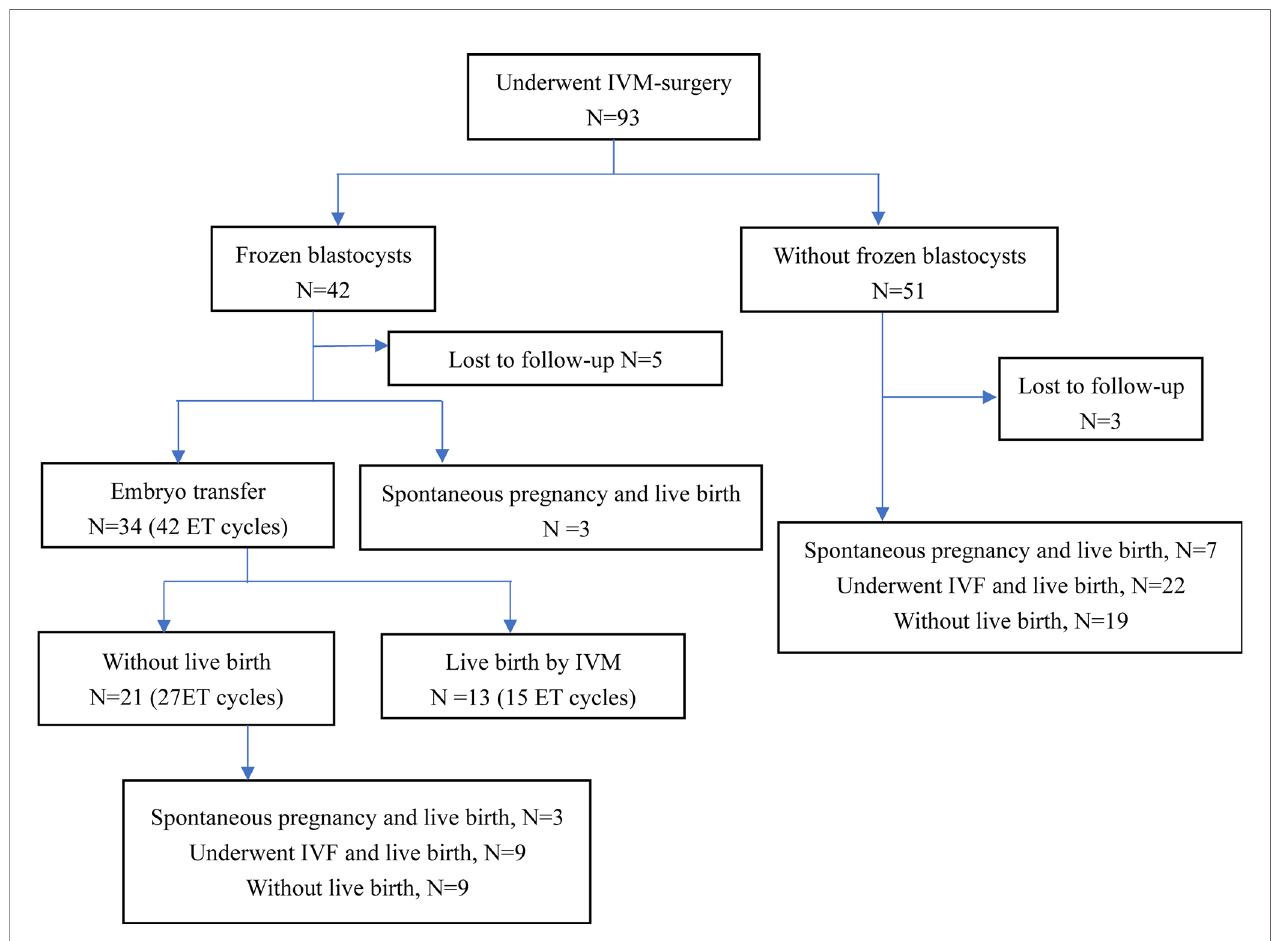
FIGURE 1 | Reproductive outcomes of patients with IVM-surgery. ET, embryo transfer; IVM, in vitro maturation; IVF, in vitro